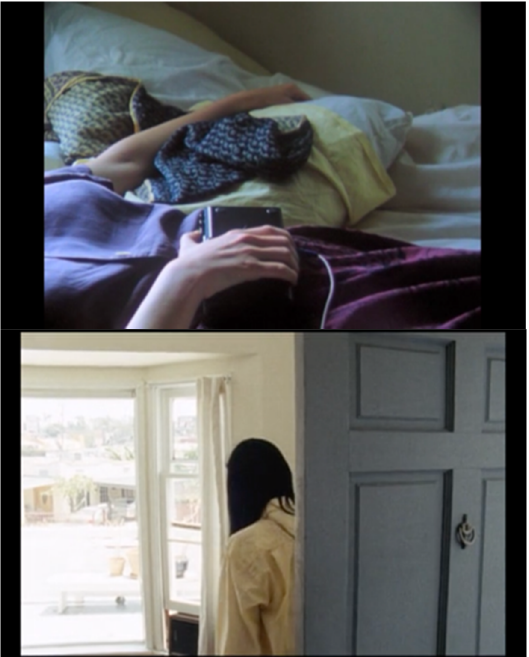
Figure 4. My Tears Are Dry (2009) and The Room Called Heaven (2012).